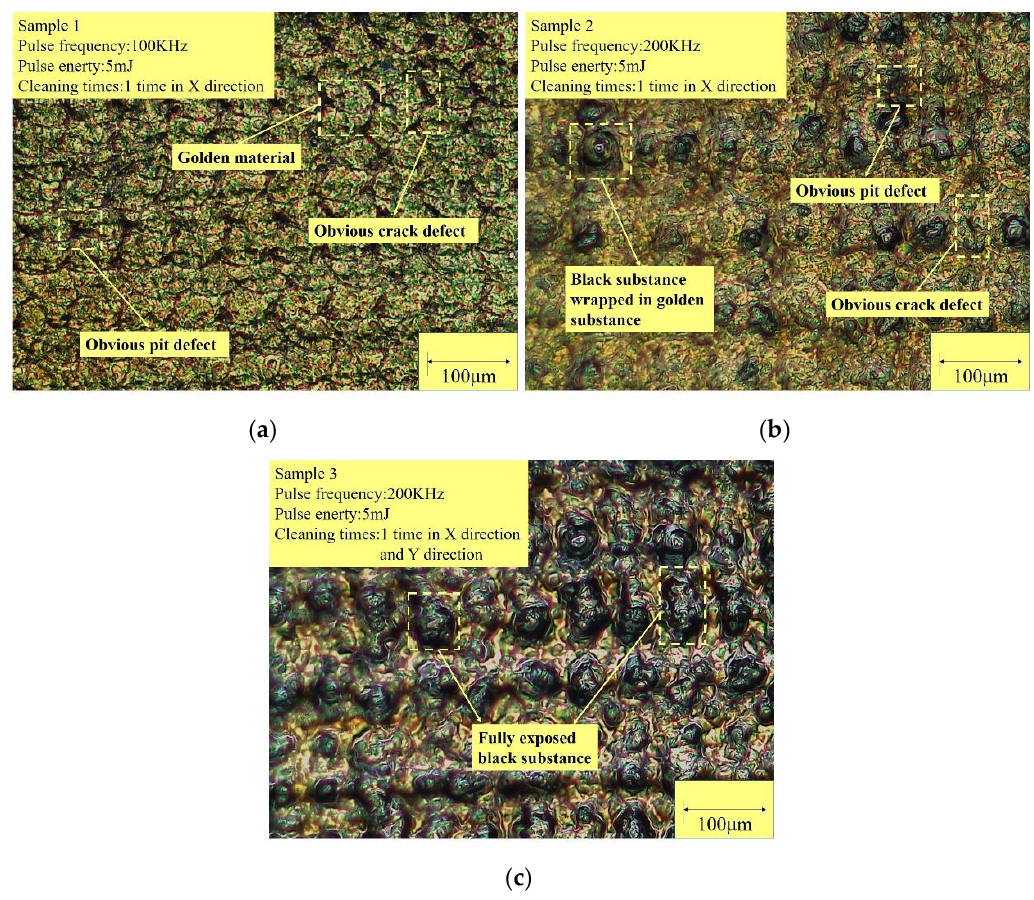
Figure 9. Light microscope morphology after sample cleaning: ( a ) 560× magnification for sample 1, ( b ) 560× magnification for sample 2, ( c ) 560× magnification for sample 3.